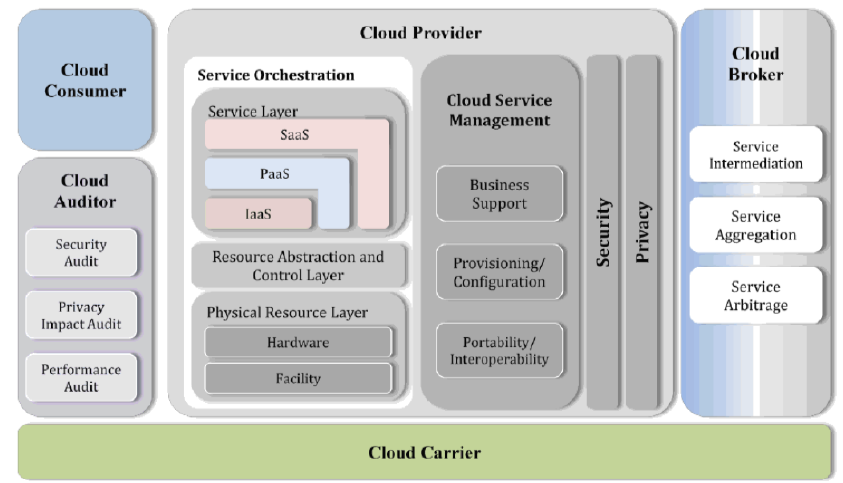
Figure 2. NIST Cloud computing reference architecture (source